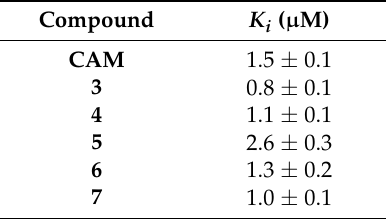
Table 3. The binding affinity constants K i of all PA–CAM.